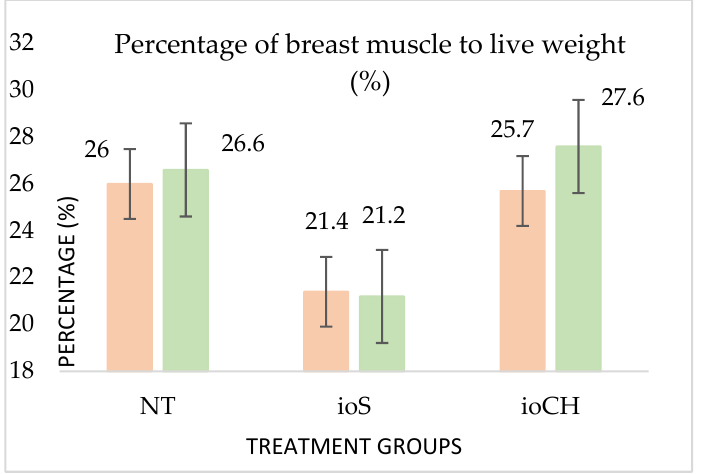
Figure 5. Effects of treatment and sex on thigh ( p = 0.6 and 0.24) and breast ( p = 0.01 and 0.4) muscle percentage compared to live weight. Pink columns represent pullets; green columns represent roosters. The error bars represent standard deviations.